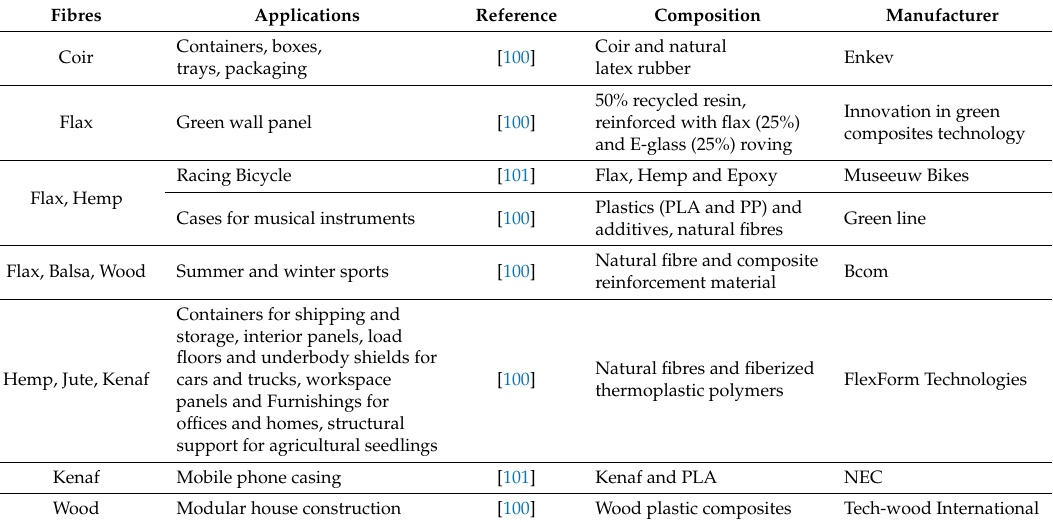
Table 10. Applications of natural fibres in other fields. Adapted from: